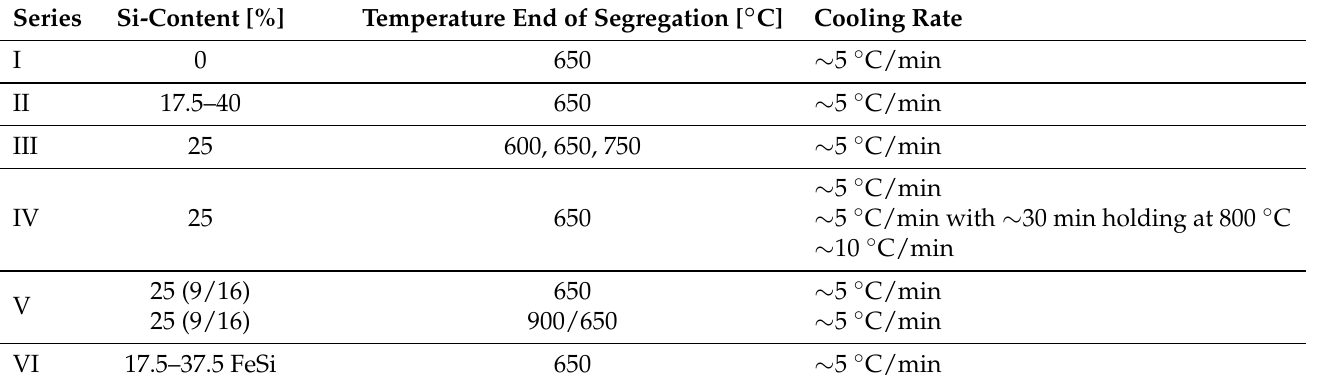
Table 3. Experimental